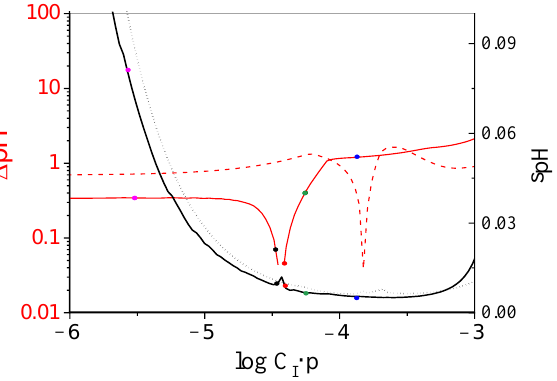
Figure 5. Trend of s pH and ∆ pH in the absence (solid curves) and presence of surfactant (dashed curves). The colored symbols refer to the curves of Figure 4a.